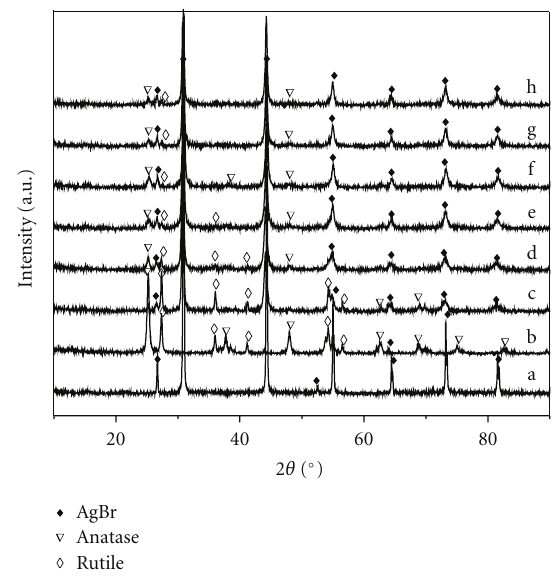
Figure 1: XRD patterns of AgBr (a), TiO 2 (b), and AgBr/TiO 2 with di ff erent mass ratios of m AgNO 3.5; (h)